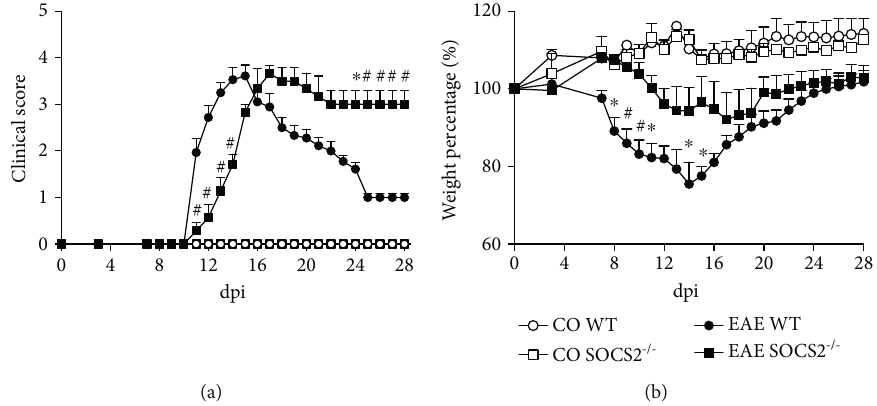
Figure 2: Regulatory role of SOCS2 during EAE. WT and SOCS2 -/- mice received an injection of MOG EAE. (a) Score was monitored by clinical signs comparing WT with SOCS2 -/- mice. (b) Weight loss percentage also was assessed daily comparing WT with SOCS2 -/- animals. Unimmunized WT and SOCS2 -/- mice were used as controls ( n = 10 WT and 9 SOCS2 -/- ). Data represent the mean ± SEM . ∗ p = 0 : 05 ; # p = 0 : 01 (statistical signi fi cance was performed by Student ’ s T -test or two-way ANOVA, with Tukey posttest).